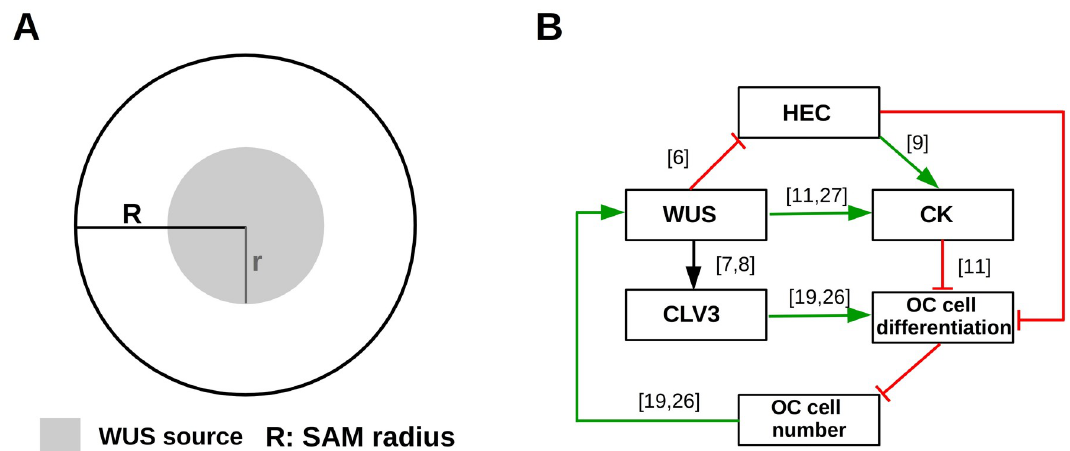
Fig 2. Overview of SAM geometry and regulatory feedbacks. (A) The SAM is modelled as a disc of radius R . The domain where WUS is produced is modelled as a concentric disc of radius r . (B) Regulatory signals: activating feedbacks are indicated in green, inhibiting feedbacks are indicated in red. The depicted interaction network functions at each position of the meristem. The expression domains of the respective factors evolve dynamically as a result of the interaction network, the initial condition and the diffusion of the factors. The number of OC cells determines the radius r . The OC is located below the SAM. The numbers in brackets correspond to the references on which the respective interaction is based.